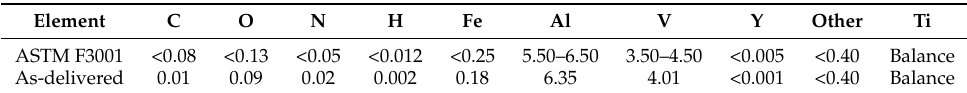
Table 1. Chemical composition of the as-delivered powder compared to ASTM requirements.